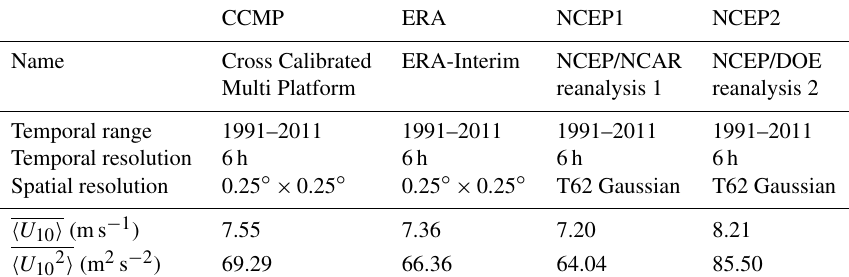
Table 1. Wind products used in this study. U 10 represent the wind speed measured 10m above sea level. (cid:104) U 10 (cid:105) and (cid:104) U 102 (cid:105) represent the global 21-year monthly mean and the second moment on a centered 1 ◦ × 1 ◦ spatial resolution grid, respectively.